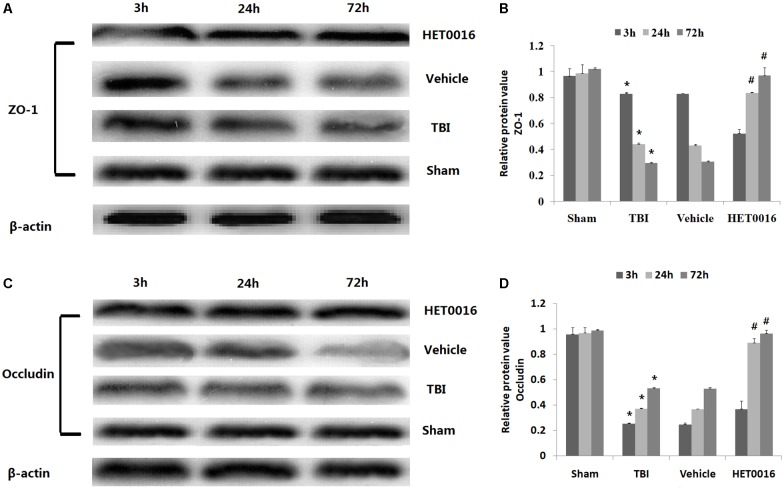
The effect of HET0016 on the expression of ZO-1 and occludin at 3, 24, and 72 h after injury. (A,B) Representative photos and the quantitative analysis of the ratio of ZO-1. (C,D) Representative photos and the quantitative analysis of the ratio of occludin. ∗P < 0.05 compared with the corresponding sham group at the same time point; #P < 0.05 compared with the vehicle-treated group.